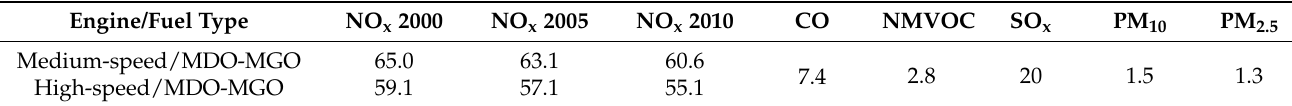
Table 7. Tier 2 engine emission factors (kg/t) for hoteling [38,43].